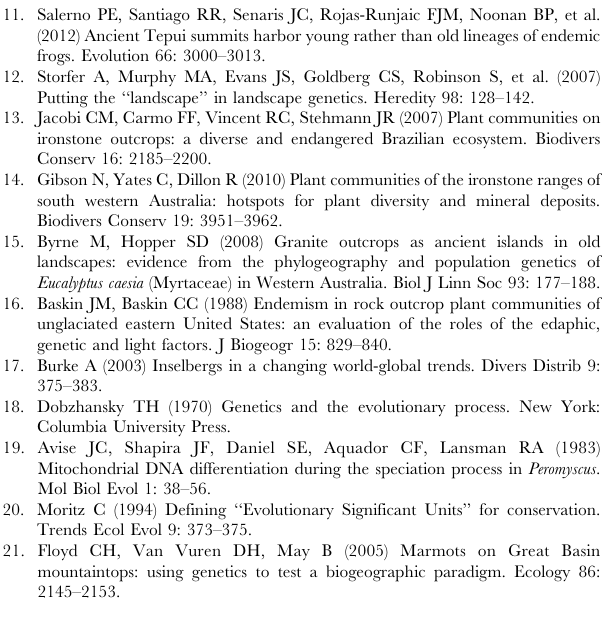
Table S1 Specimen information, including spatial co- ordinates from UTM zone 50 J and haplotype number based on combined CO1 and 16 S mtDNA data. Samples from Windarling and Kooylanobbing (bold) are from specimens lodged at the Western Australian Museum, registration numbers